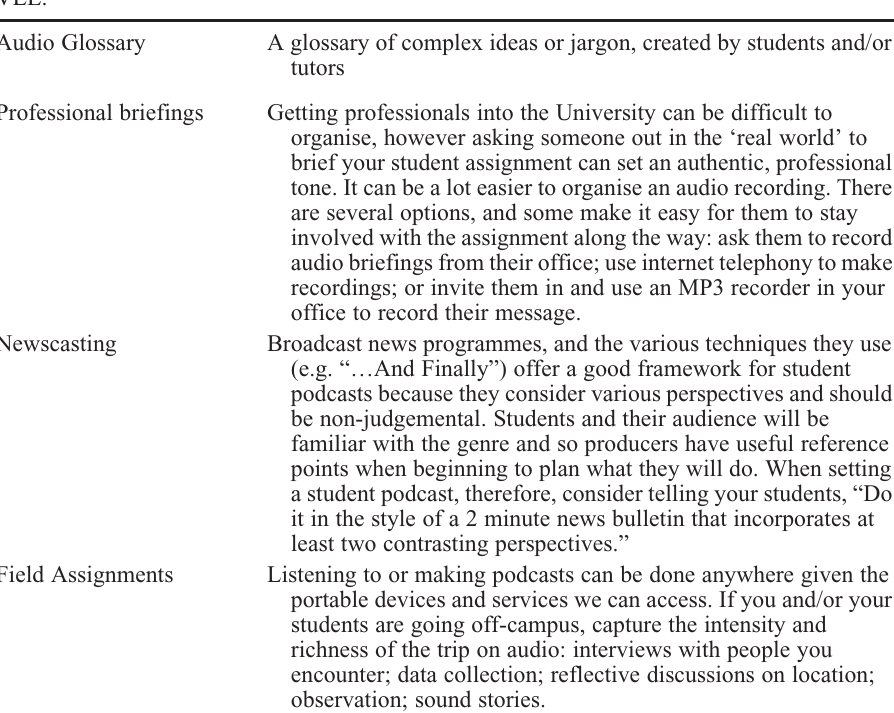
Table 1. Examples of idea announcements for educational podcasting from the Closer! pilot